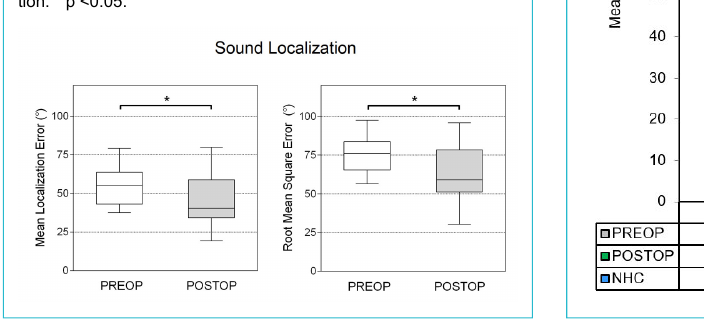
Figure 7: Mean absolute (left) and root mean square (right) locali- sation errors assessed preoperatively and 12 months post activa- tion. * p <0.05.